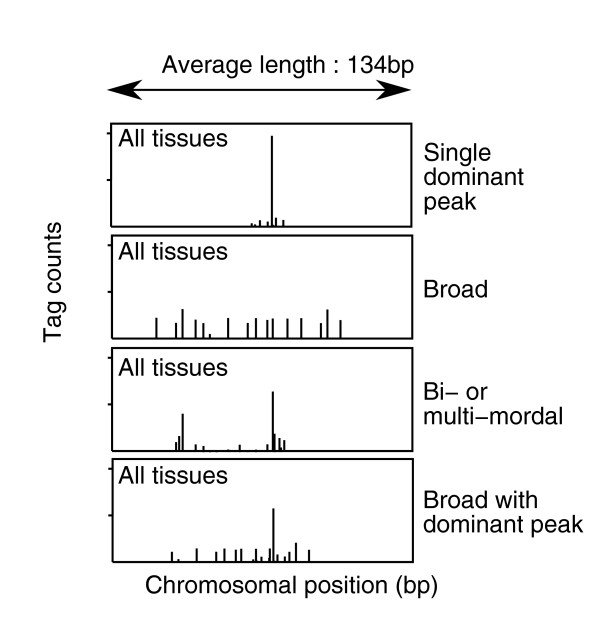
Four shape classes of static TSS usage. Tag clusters were classified into four classes based on CAGE tag counts from all tissues. The tag counts are displayed by histograms, where the x-axis indicates genomic coordinates or chromosomal location, and the y-axis indicates the total counts of CAGE tags. bp, base pairs; CAGE, cap analysis of gene expression; TSS, transcription start site.